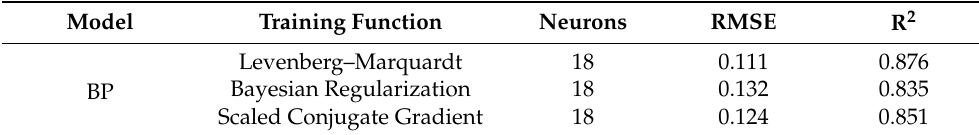
Table 9. BP neural network modeling results based on different training